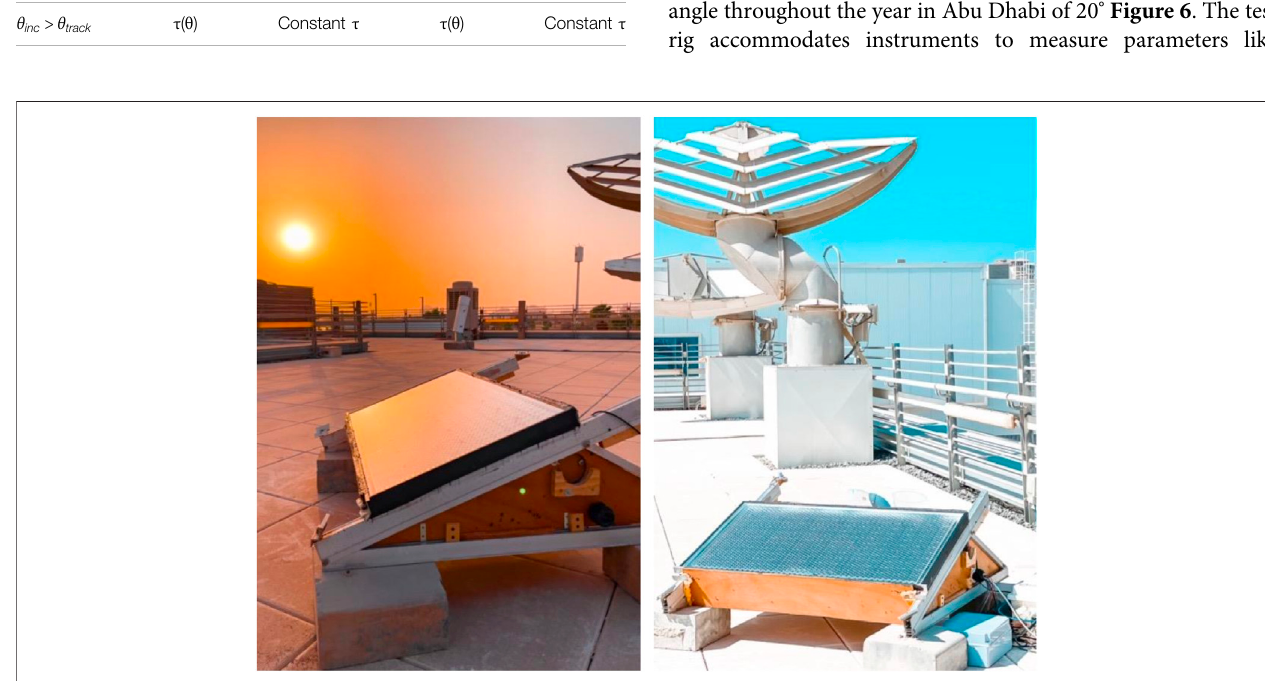
FIGURE 6 | Test-rig with the Insolight module on